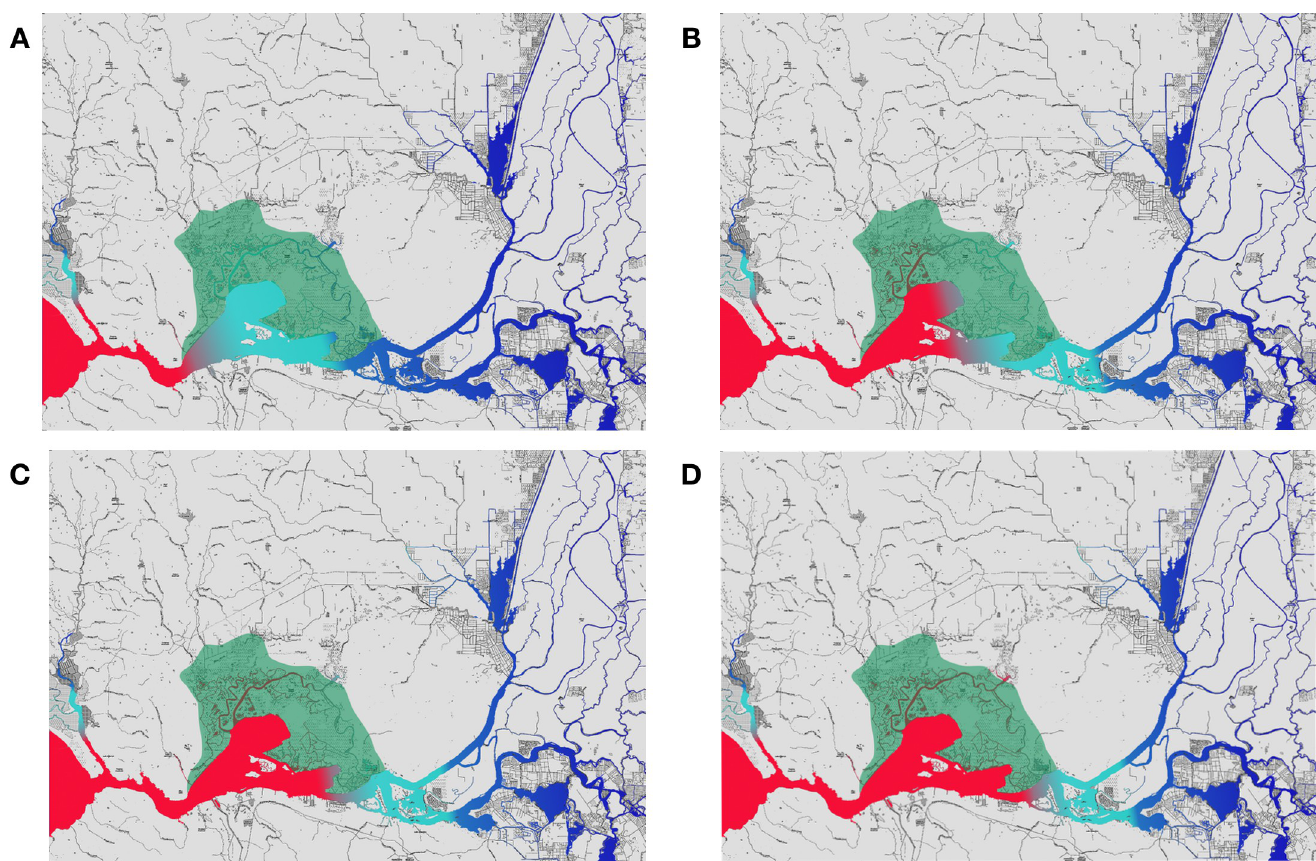
Fig 6. Comparison of area and location of the mixing zone (salinity 1.0–6.0) among 2011–2014 (A-D), October. The area with red, light blue, and dark blue color represent salinity > 6.0, 1.0–6.0, and < 1.0, respectively. The Suisun Marsh/Montezuma Slough area is indicated by green. Salinity data were obtained from the California Department of Fish and Wildlife FTP server (ftp://ftp.dfg.ca.gov/TownetFallMidwaterTrawl/). The base map was downloaded from the U.S. Geological Survey